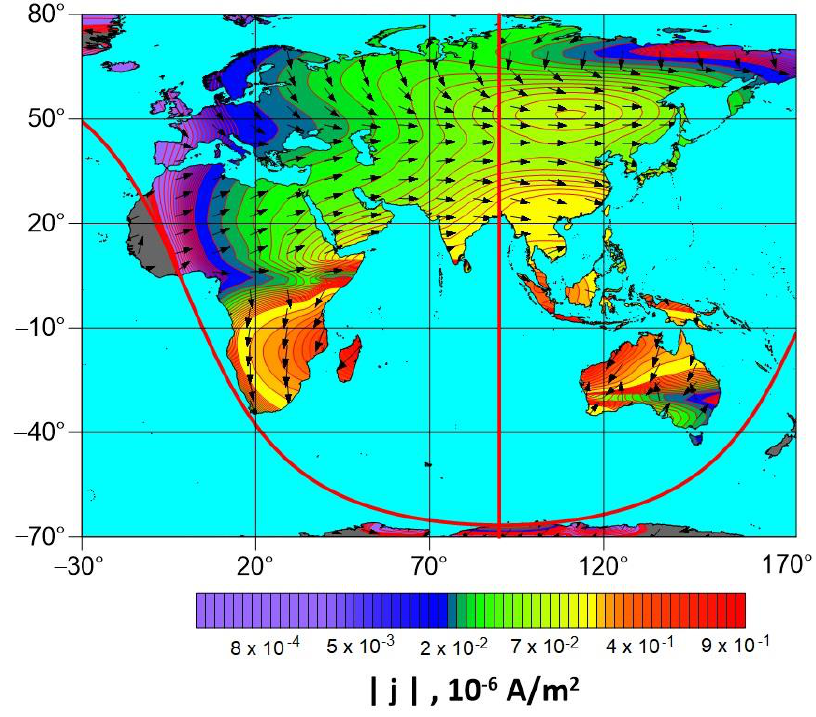
Figure 14. Spatial distribution of the amplitude of the maximum density of the electric current modulus and the direction of its vector. The red vertical line shows the position of the subsolar meridian.